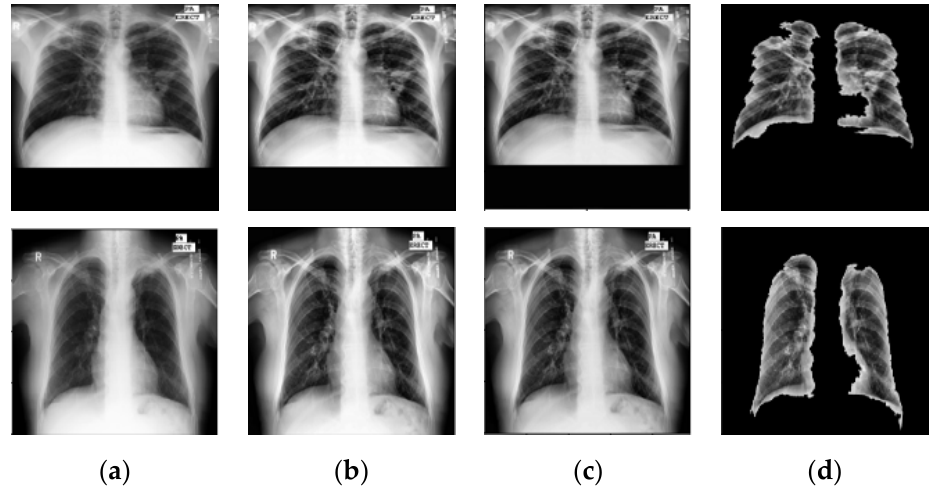
Figure 6. ( a ) Input Images—Abnormal; ( b ) Equalized images; ( c ) Weiner Filter; ( d ) Segmented images. Figure 3 was processed and taken from normal images of the CHN